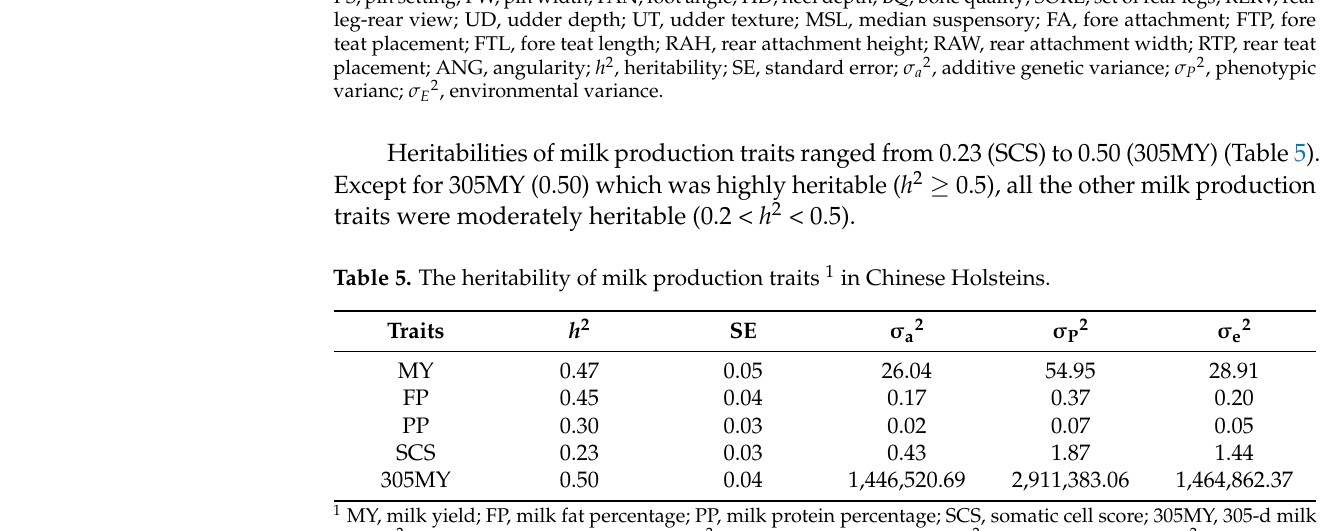
from − 0.75 (UD and ANG) to 0.95 (ST and TS). ST and TS (0.95), HFE and TS (0.54), HFE and PW (0.93), HFE and FTL (0.69), TS and PW (0.65), TS and FTL (0.72), TS and ANG (0.69), CW and LS (0.76), CW and PW (0.60), LS and PS (0.62), LS and UT (0.88), UT and FTL (0.64), UT and ANG (0.88), MSL and FTP (0.67), and MSL and RTP (0.69) showed high correlations (shown in bold). Phenotypic correlations between conformation traits ranged from − 0.52 (UD and ANG) to 0.68 (ST and TS) (Figures 1 and 2). Detailed information can be found in the Supplementary Materials (Table S1 and Figure